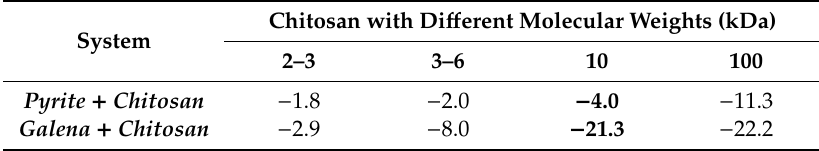
Figure 5. The effect of the addition of chitosan with different molecular weights (400 g/t) on the zeta potential of ( a ) pyrite and ( b ) galena. Table 2. Zeta potential changes (mV) of pyrite and galena in the presence of chitosan with different molecular weights (400 g/t) at pH 8.